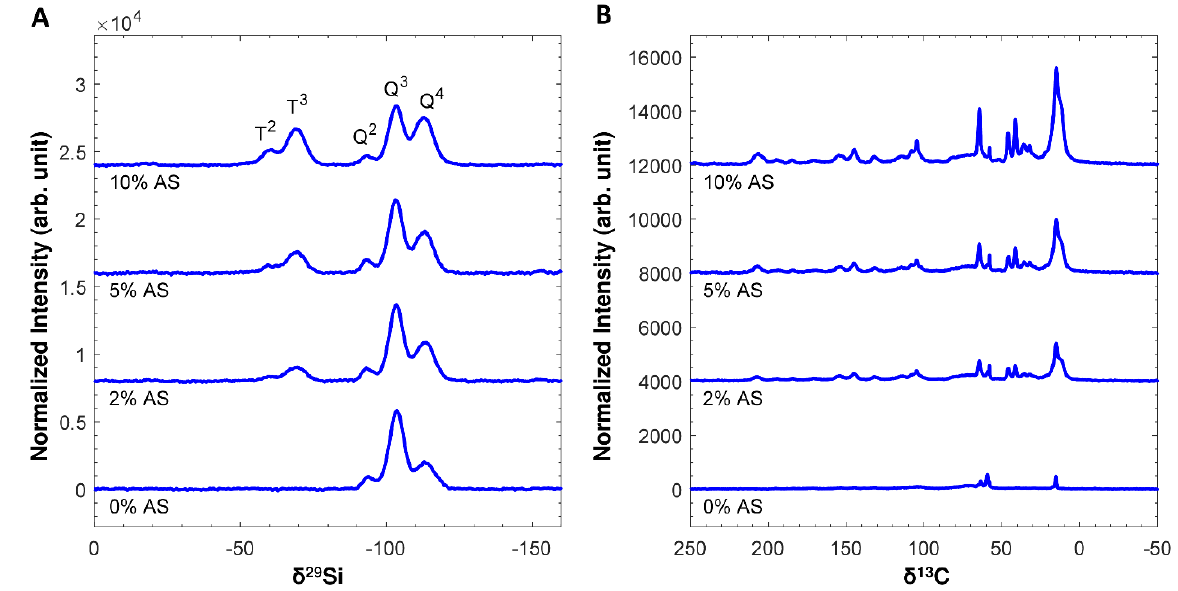
Figure 3. 1 H- 29 Si CP MAS NMR spectra ( A ) and 1 H- 13 C CP MAS NMR spectra ( B ). All spectra are normalized to the same sample mass and same number of scans. The assignment of the 29 Si resonances is indicated in the figure. Please refer to Figure S5 and Table S4 for the peak assignment of the 13 C